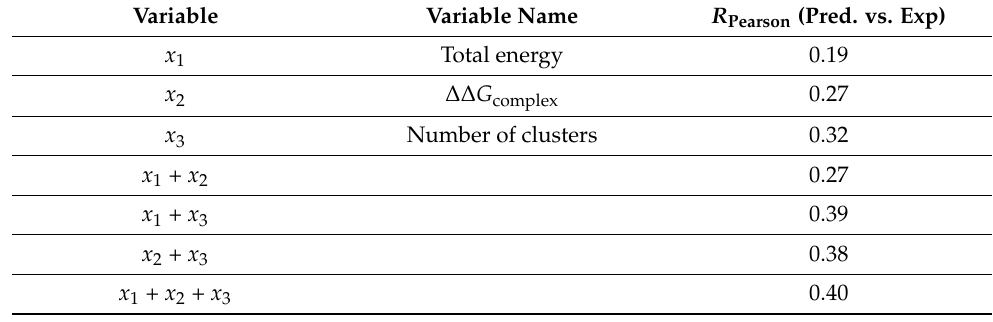
Table 2. Optimization of binding interaction predictor variables based on the (multiple) linear regression. For each model, Pearson’s correlation coefficient, R Pearson , was calculated to assess the significance of the predictive power that the model may show.